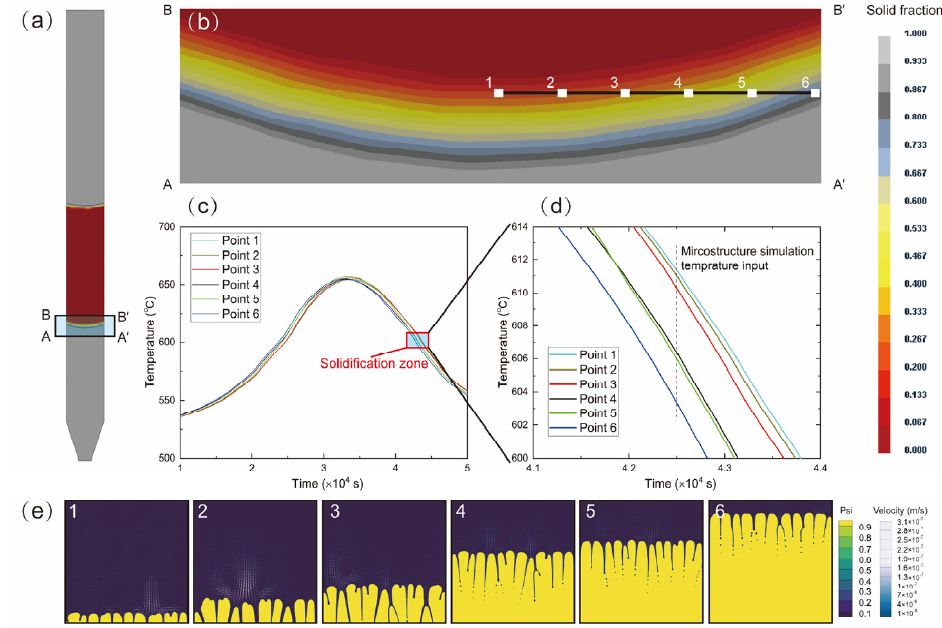
Figure 5. Macro-micro-coupling simulation of zone melting process of bismuth telluride-based crystal materials. ( a ) Macro temperature field simulation of the zone melting process, ( b ) the morphology of solidification interface and the position of six temperature observation points, ( c ) the temperature change profile of observation points throughout the zone melting process, ( d ) the temperature change profile near the melting point, ( e ) microstructure growth simulation.